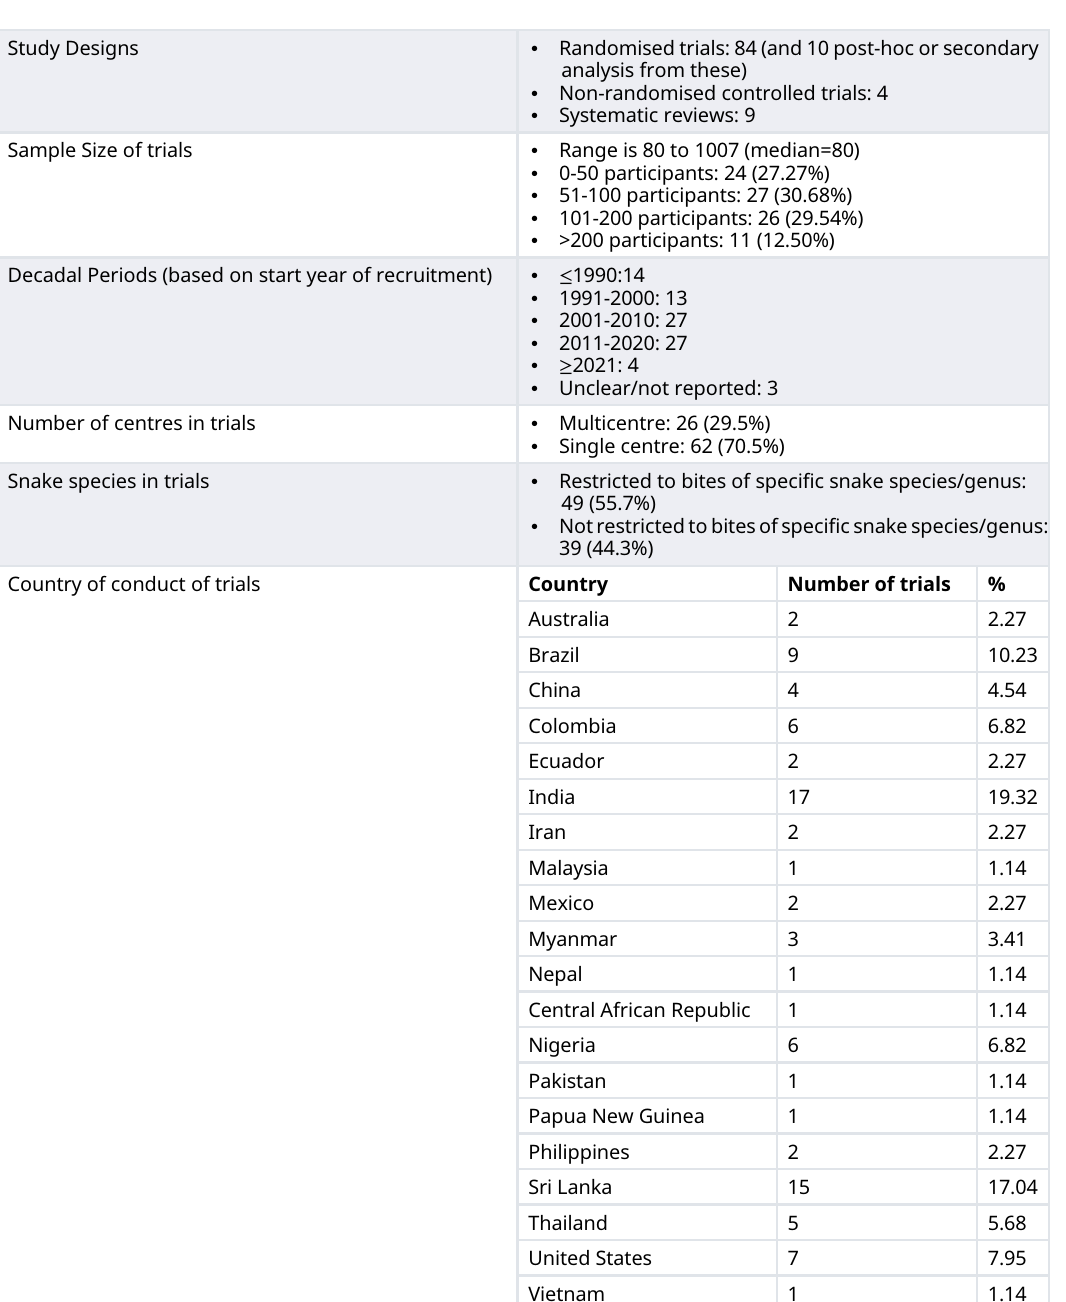
Table 1. Characteristics of included studies. Study